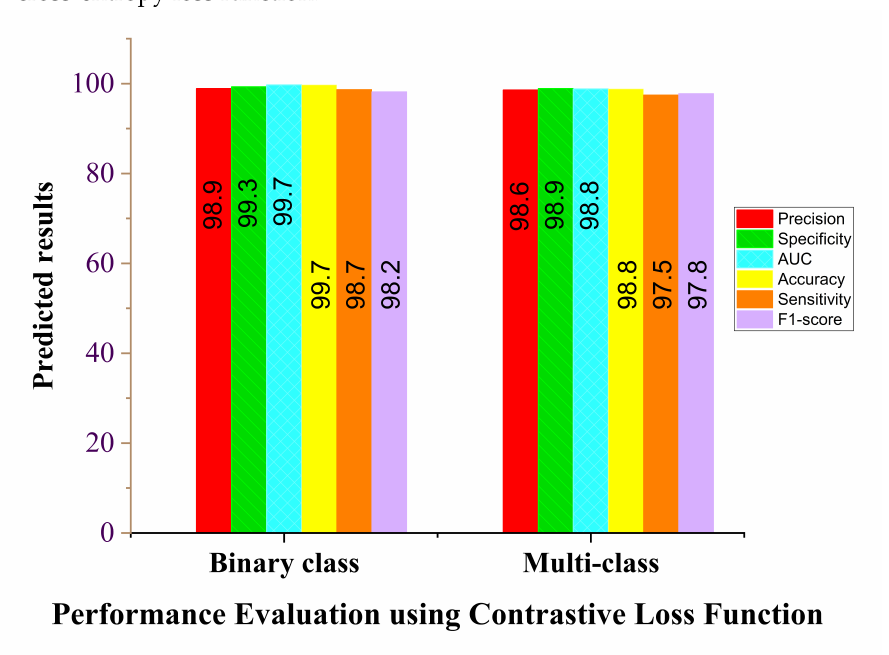
Figure 5. Contrastive loss function report for binary class and multi-class.